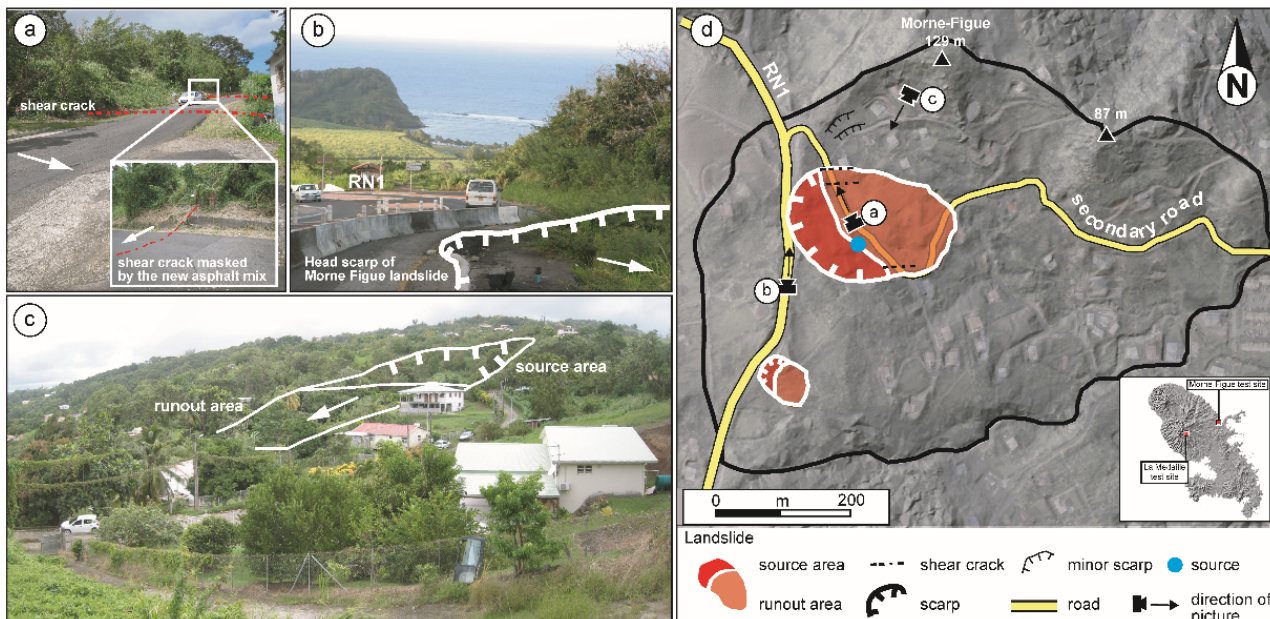
Figure 3. Morne-Figue area; ( a ) picture of the limit north of the Morne-Figue landslide (the bumps on the road are produced by the shear cracks of the landslide); ( b ) main scarp of the Morne-Figue landslide in 1989 [65] ; ( c ) panorama of the Morne-Figue area; ( d ) main morphological landslide features (the map was produced with an orthophoto from IGN, 2015, and hillshade map from Litto3D DTM, IGN, 2010).